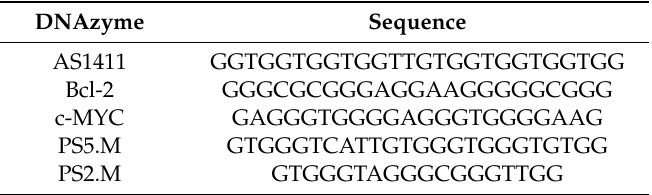
Table 1. Sequences of DNAzymes used in this study. The DNA sequences are written in 5 (cid:48) to 3 (cid:48)